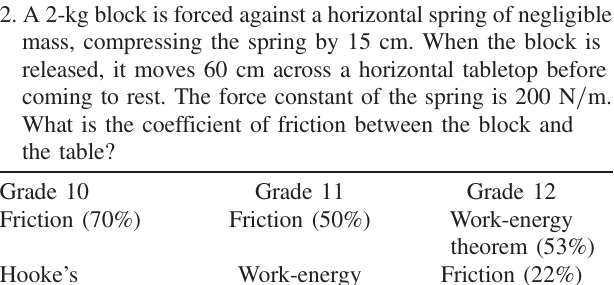
TABLE IV. The percentage of the top 3 categories for Q2 created by the students in different